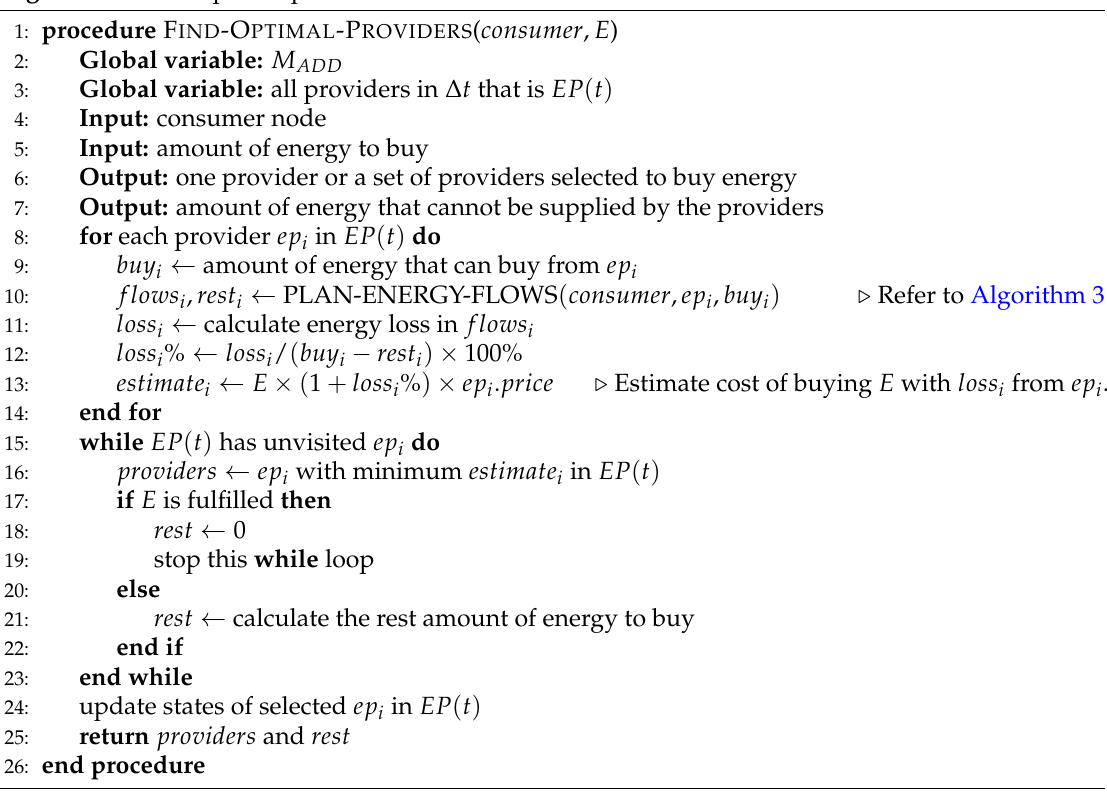
Algorithm 4 Find optimal providers for a consumer